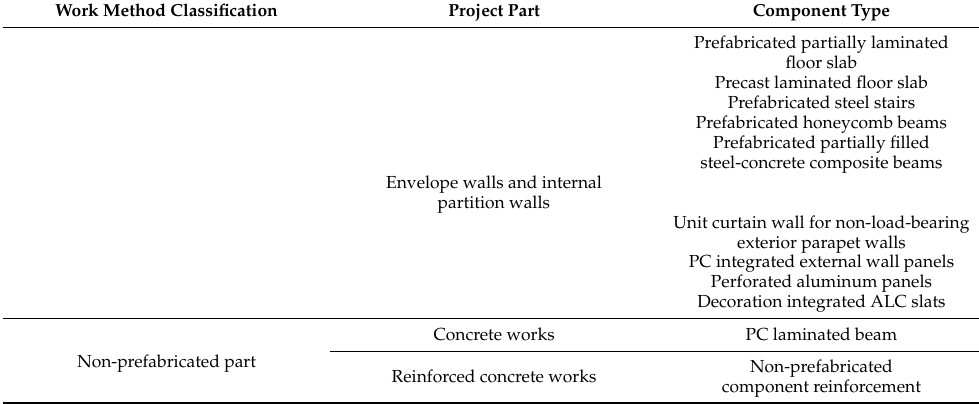
Table 5. Summary of calculation results of OM emission factors for six regional grids in China in